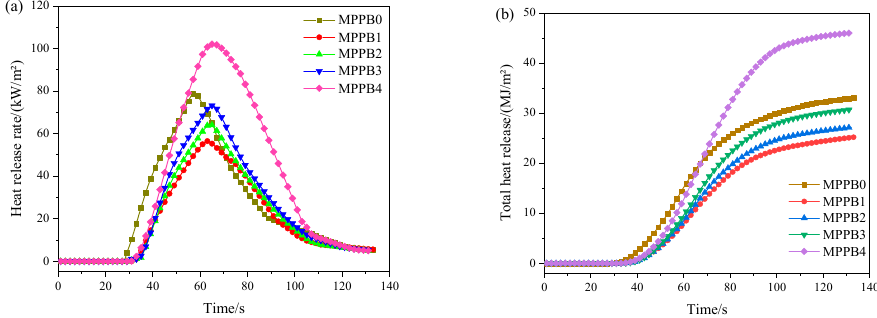
Figure 8. Heat release rate ( a ) and total heat release ( b ) curves of the MPPBs coatings. Digital photographs of the MPPBs char collected from the cone calorimeter test are presented in Figure 9. It is clearly seen that the thickness and compactness of the char layer are gradually decreased with increasing molecular weight of PEG-BA, and MPPB1 coating containing PEG200-BA forms the highest and densest char concomitant with the best synergistic effect among the samples. When PEG800-BA is added, the resulting MPPB4 coating forms the lowest and loosest intumescent char, corresponding to the highest HRR and THR values among the samples. The above results indicate that the low molecular weight of PEG-BA can serves as an effective synergist for enhancing the flame retardancy of the coatings, and the high molecular weight of PEG800-BA is not suitable for the transparent coatings.